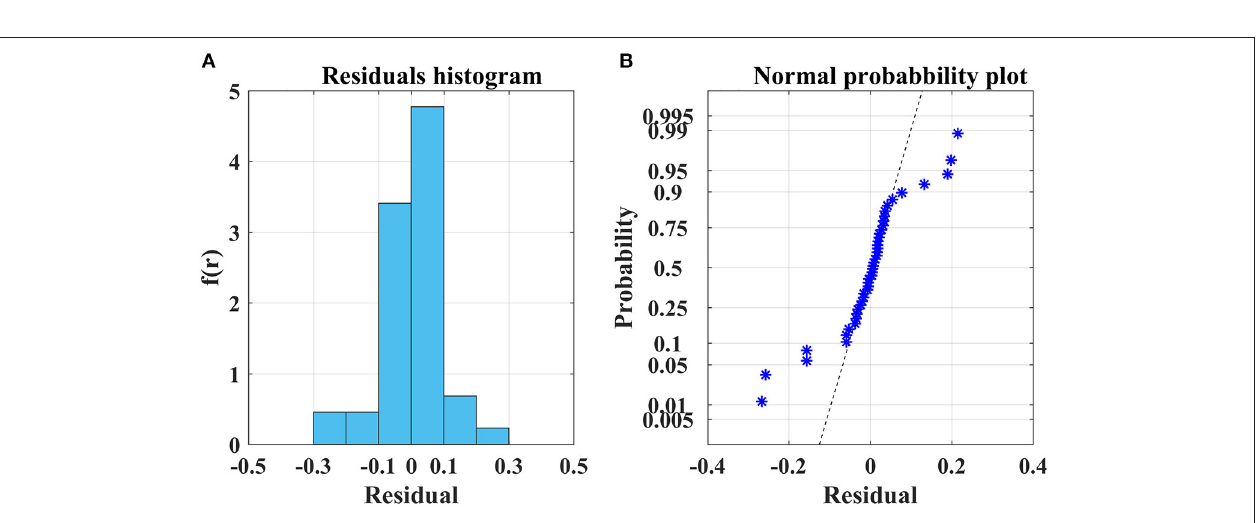
FIGURE 3 | Residuals analysis of estimated TOC from the CFPR method. (A) Residuals distribution histogram, (B) Residuals probability